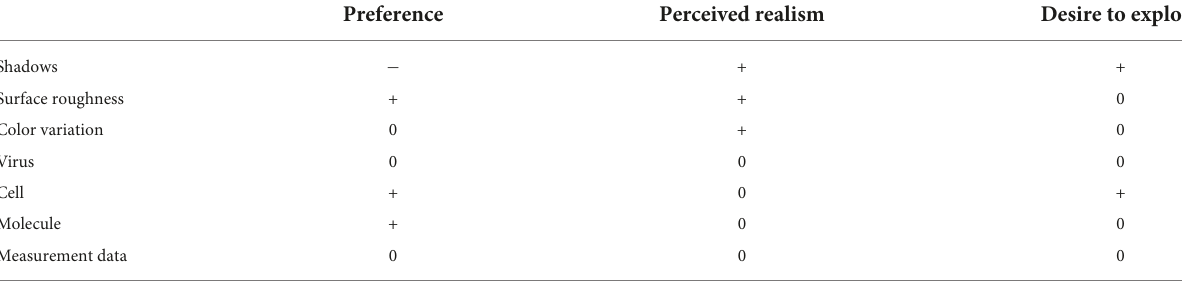
TABLE 6 Summary of findings from binary logistic regression analysis. Preference Perceived realism Desire to explore